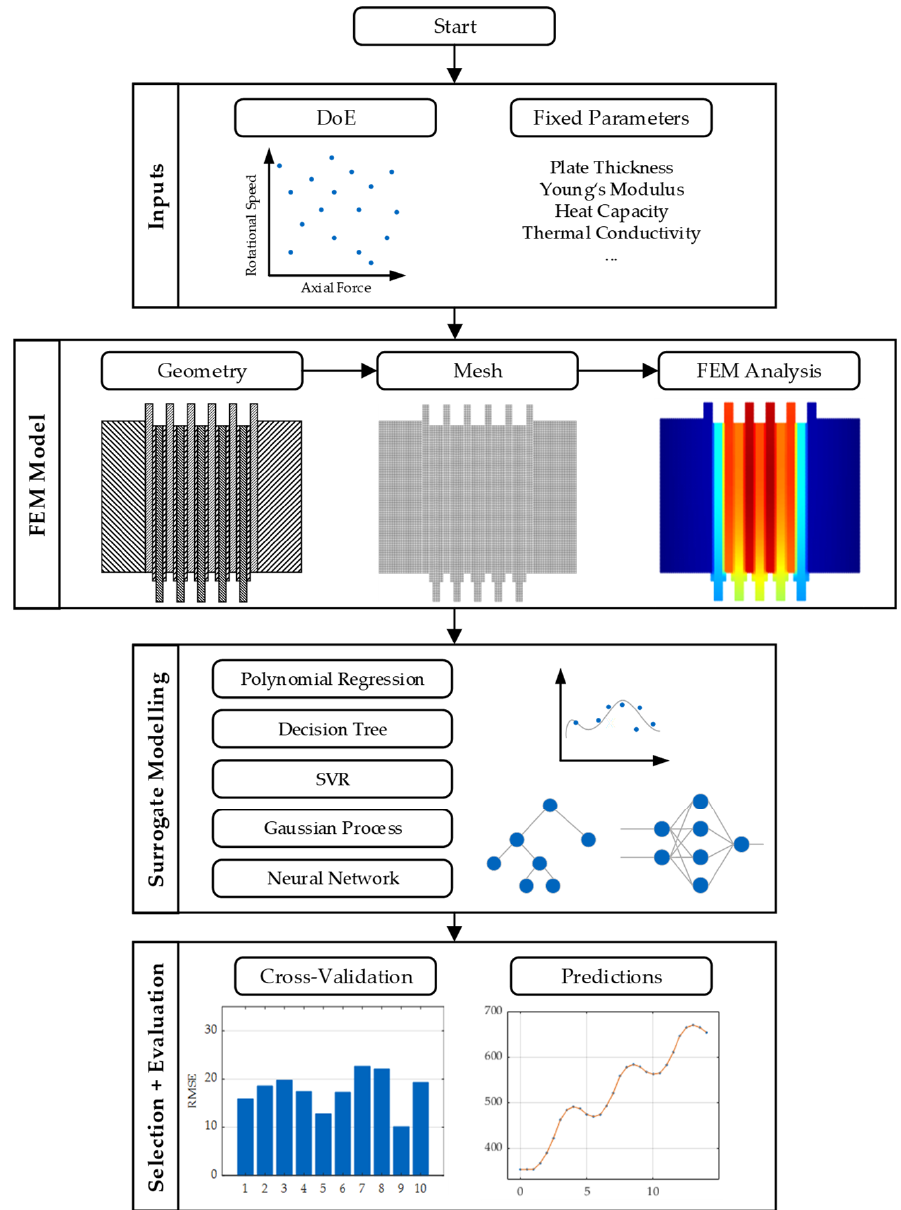
Figure 1. Graphical representation of the general procedure.